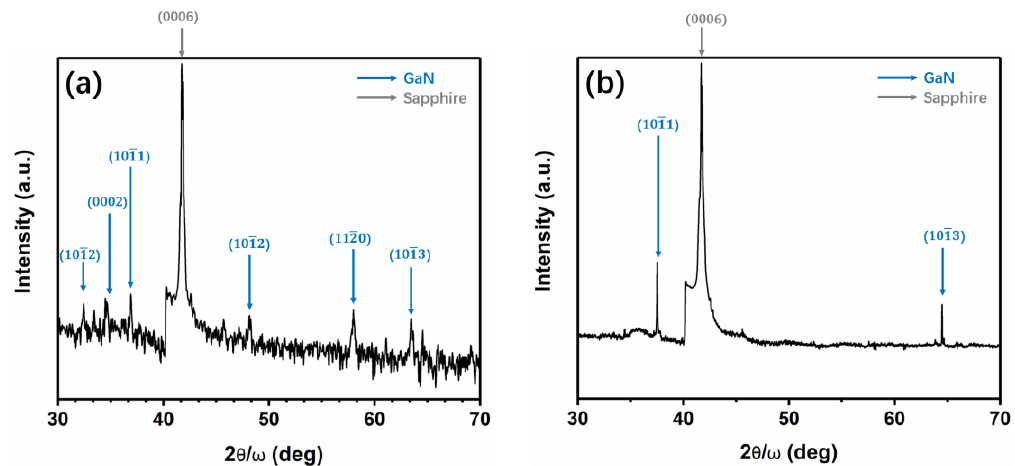
Figure 7. ( a ) The STEM image of the GaN film on the 10 nm sputtered AlON/PSS. ( b ) SAED patterns of the GaN film on the 10 nm sputtered AlON/PSS template.